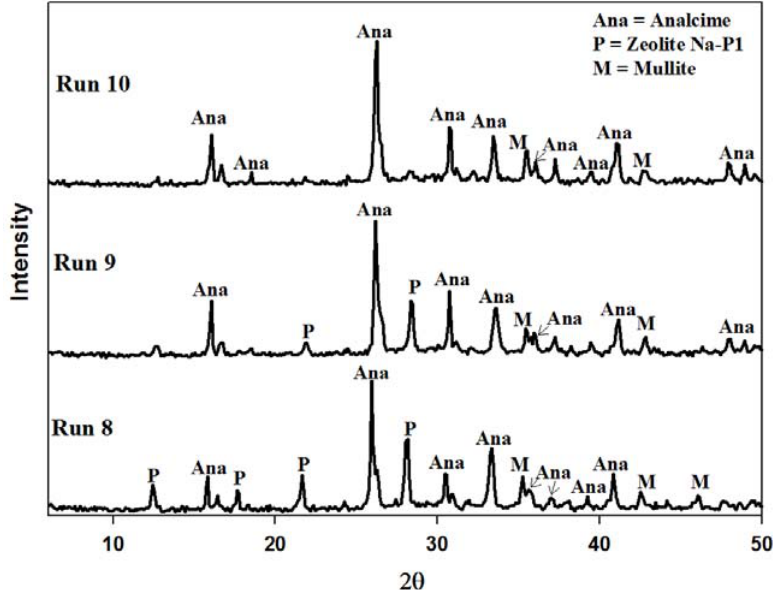
Figure 12. XRD patterns illustrating reproducibility of results depicted in Figure 8 (third results